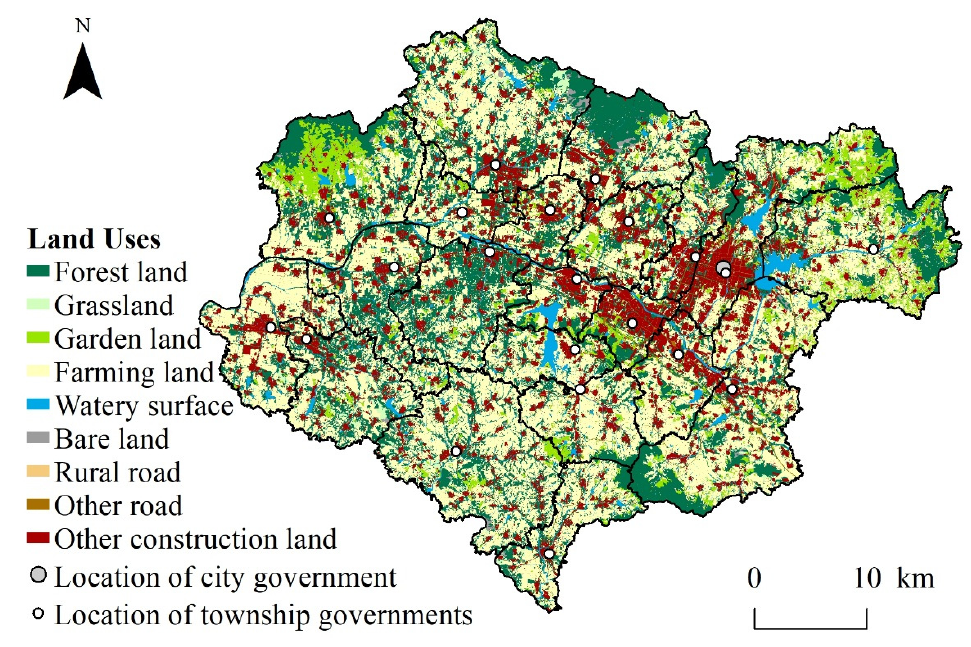
Figure 3. Land uses of Xintai